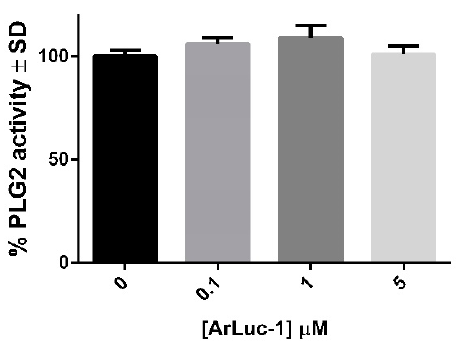
Figure 3. Luminescence (RLU) of PLG2 as a linear function of LH 2 concentration in the presence of 2.5% DMSO. All points are expressed as mean ± SD.